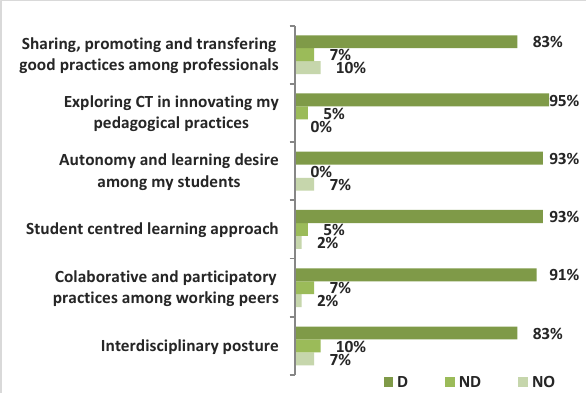
Figure 3. Percentage of answers regarding the professional